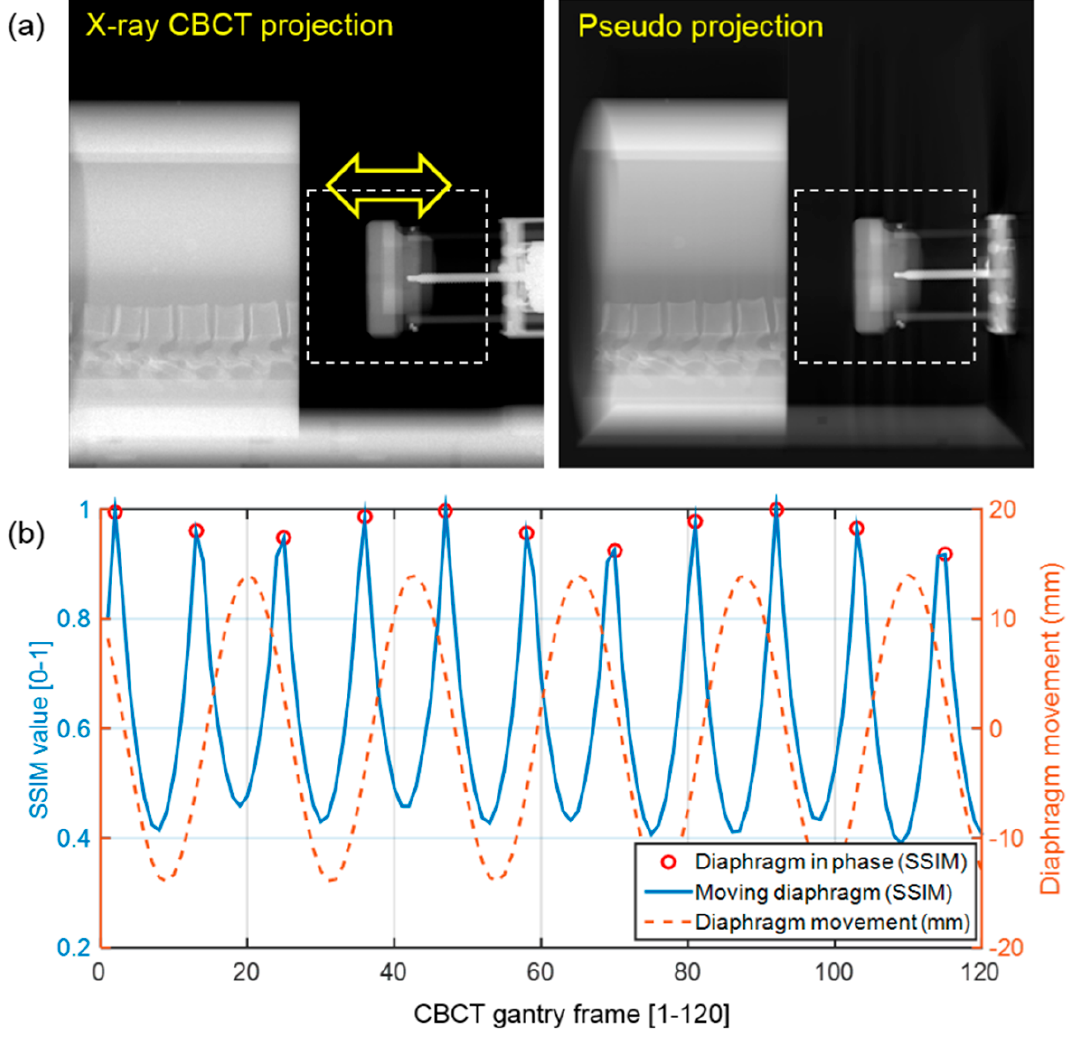
Figure A1. Evaluation of similarity between our DRR images and their corresponding actual X-ray images using dynamic diaphragm phantom data with motion control. ( a ) Representative x-ray projection and pseudo projection (i.e., DRR) images. ( b ) SSIM between X-ray projections of a moving phantom and DRRs of a static phantom for each frame.